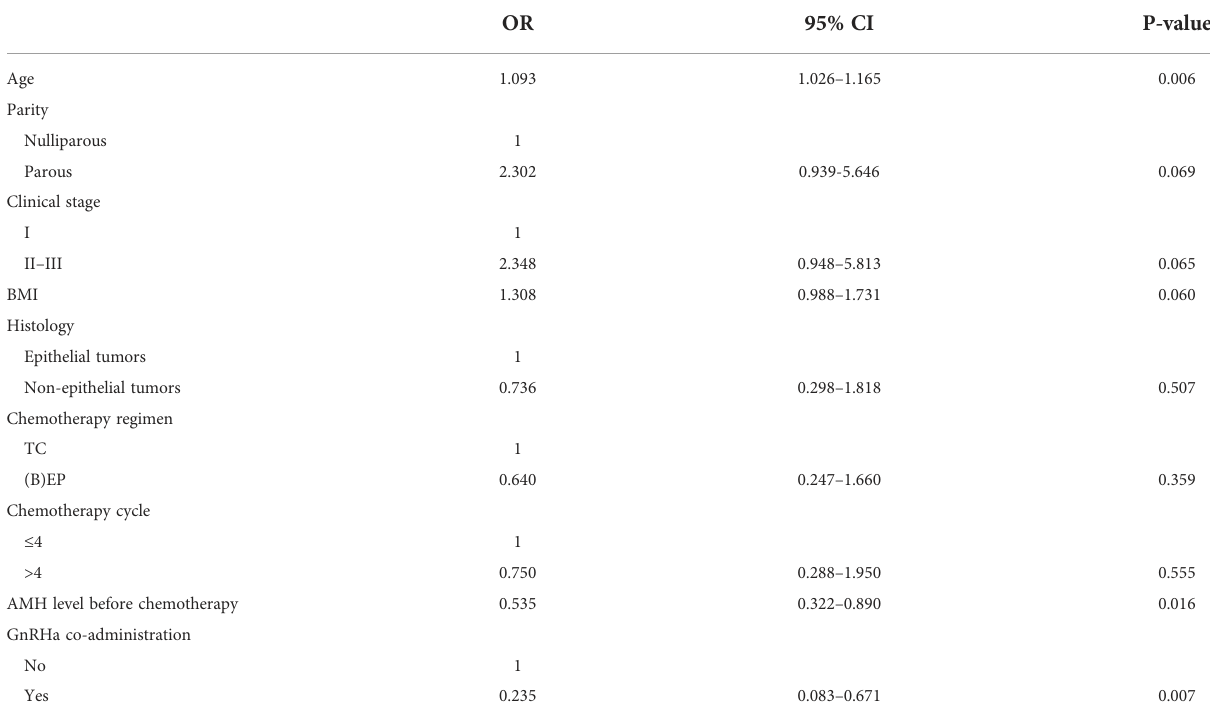
TABLE 5 Univariate logistic regression analysis of factors contributing to AMH <1.1 m g·L -1